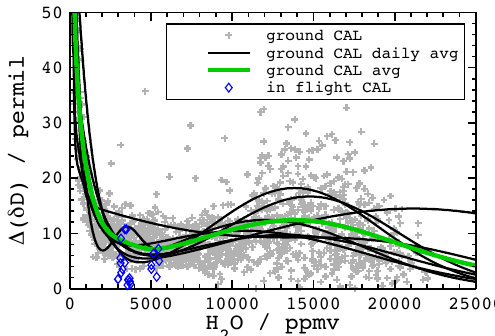
Figure 4. Uncertainty analysis for all flight days. Grey symbols: deviation of individual 1Hz calibration measurements from cali- Fig. 4: Uncertainty analysis for all flight days. Grey symbols: bration standard; black lines: daily fit of (cid:49)(δ D ) (Eq. 2); green line: Deviation of individual 1 Hz calibration measurements from campaign average of (cid:49)(δ D ) . Inflight calibration-gas measurements calibration standard; black lines: daily fit of ∆( δ D) (Equa- are depicted as the difference to the daily mean (absolute value) by tion 2); green line: campaign average of ∆( δ D) . In-flight the blue calibration-gas measurements are depicted as the difference to the daily mean (absolute value) by the blue symbols.